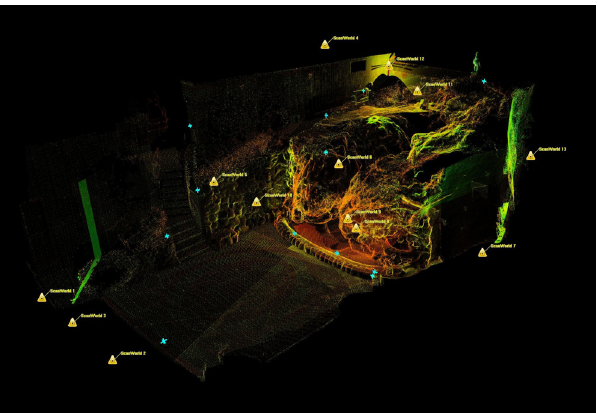
Figure 5. The acquisition project with stations and targets